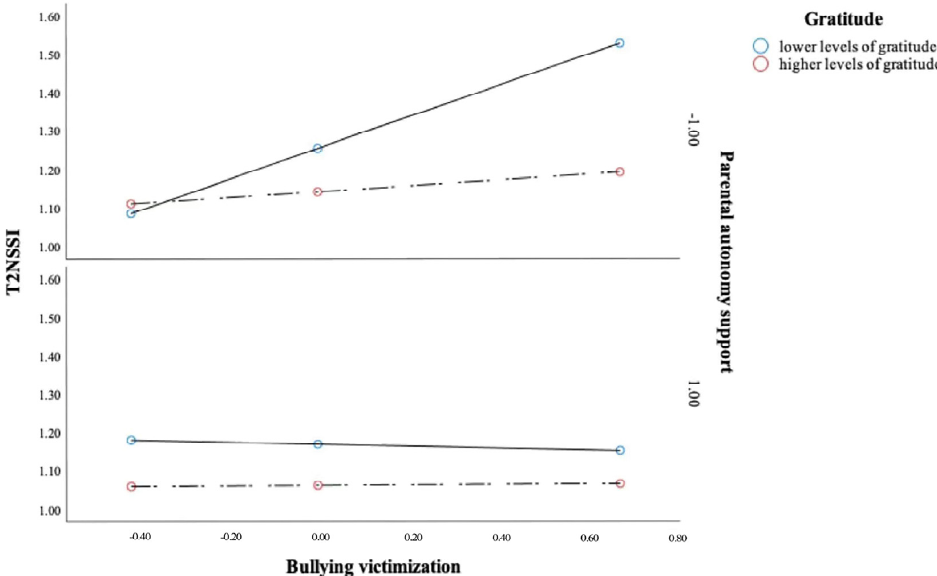
Figure 1. Interaction effect of bullying victimization, gratitude, and parental autonomy support on T2 NSSI. Parental autonomy support and gratitude were divided into two levels based on the mean: M − 1 SD and M + 1 SD. Note: Age, gender, parental educational level, and T1 NSSI were included as covariates of T2 NSSI.